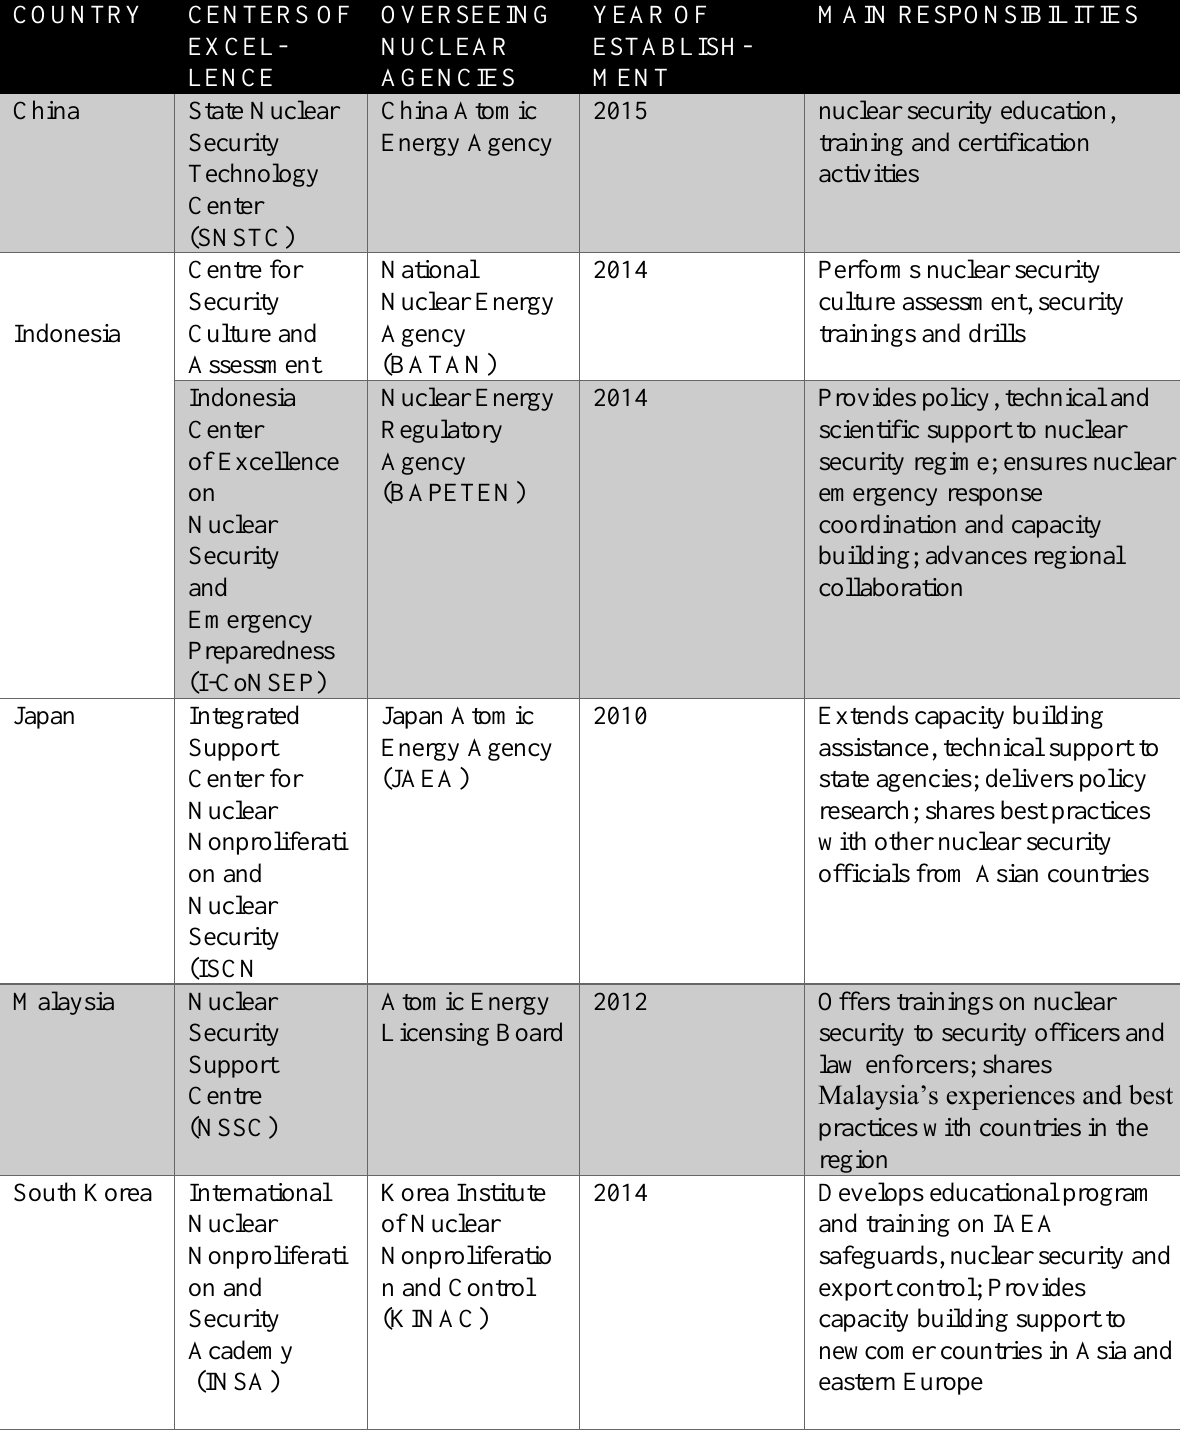
Table 2. Nuclear Security COEs in Southeast and Northeast Asia [ 27 , 28